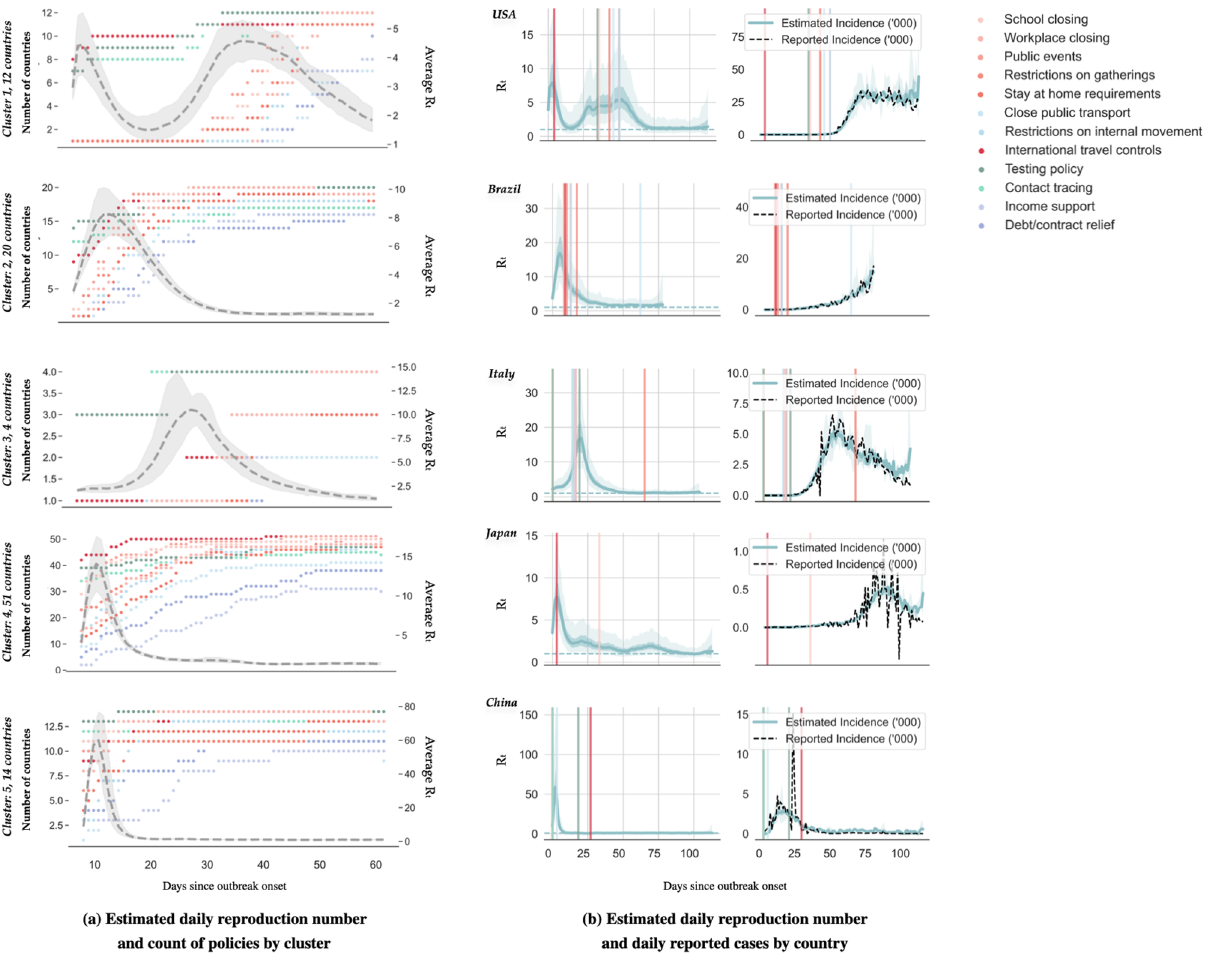
Figure 2. Patterns of early public health interventions and the evolution of effective reproduction number by cluster. ( a ) The left panel shows the estimated daily reproduction number for each cluster during the first 60 days of the epidemics. The dashed gray line represents the median and the light gray shading represents the 5th to 95th quantiles. The number of countries that adopted the corresponding selected public health intervention are displayed using colored dots. ( b ) The left side of the right panel shows the mean estimated daily reproduction number in selected countries until 15 May 2020. The right side of the right panel displays the reported (in dashed black line) and estimated average incidence counts (in solid blue line). In both cases, the light and dark blue shading represent 75% and 95% confidence intervals of the model estimate respectively, and the colored lines mark the initiation of the corresponding selected public health